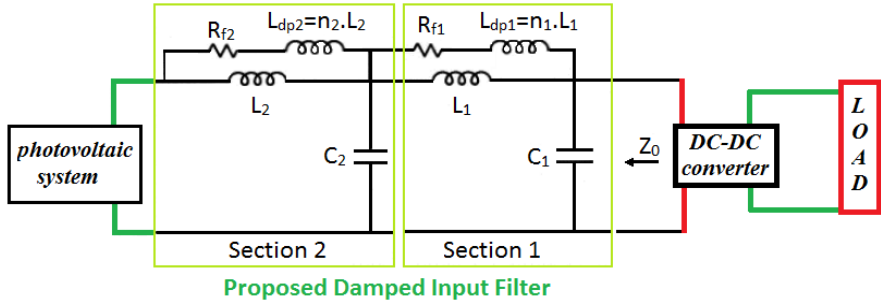
Figure 5. Suggested cascading input filer within the DC–DC converter of the PV system.